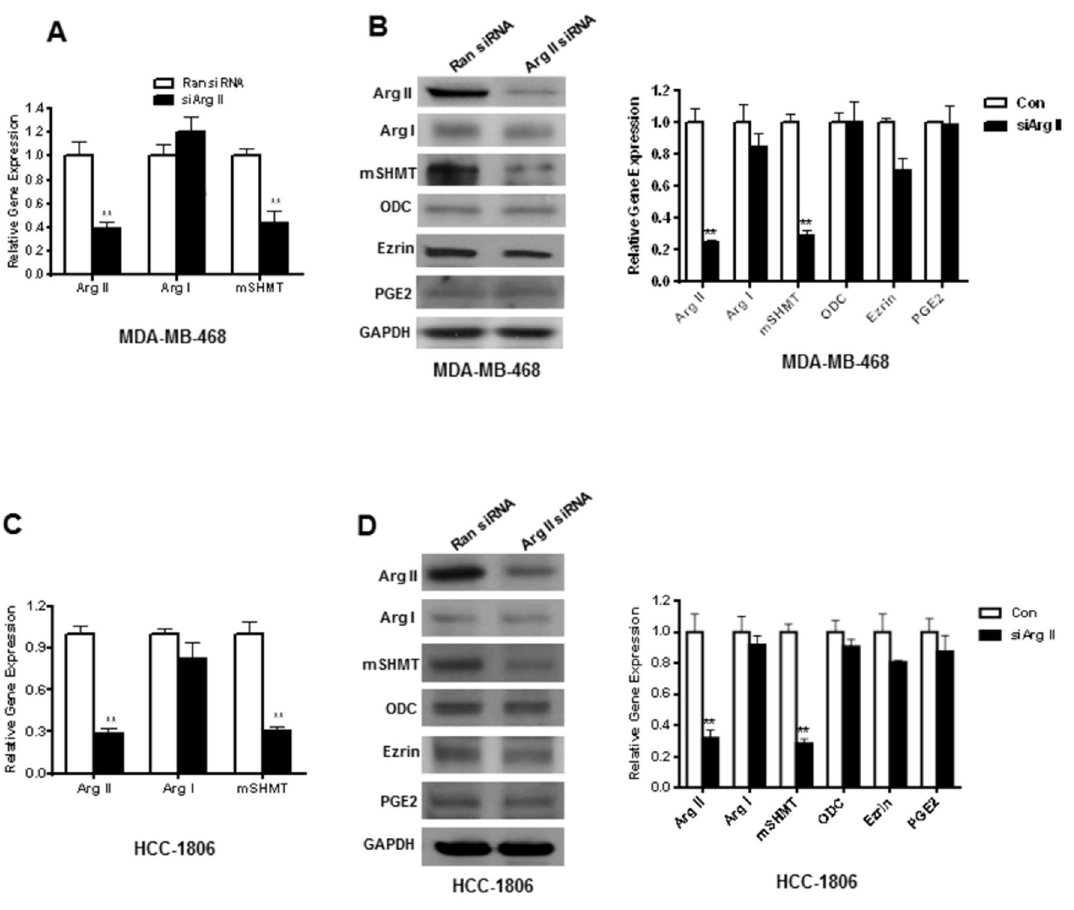
Figure 6. A-B , Selective inhibition of mSHMT gene and protein expression in MDA-MB-468 and C-D , HCC-1806 cells after siRNA-mediated inhibition of Arg II expression. A , C : Real-time quantitative PCR analysis using gene specific human primers (Arg I, Arg II and mSHMT) after normalization with GAPDH. B , D : Left panel, Western blot analysis; right panel, densitometric analysis of protein bands after normalization with GAPDH. Experiments were repeated three times and representative data are shown. *, p≤0.05; **,